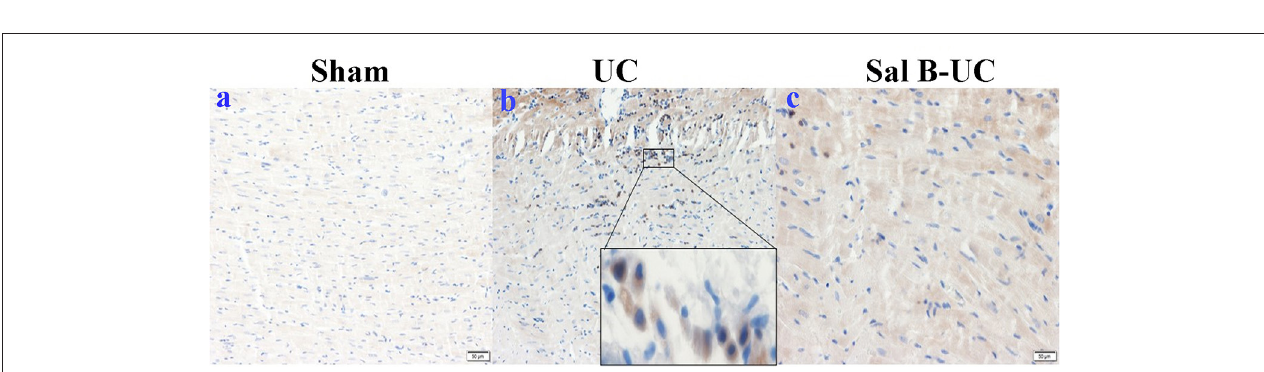
FIGURE 4 | Masson’s trichrome staining. The Masson’s trichrome images of the interstitial and perivascular area in the sham, UC, and Sal B-UC groups (50 µ m). The light blue staining indicates the severity of cardiac fibrosis. In the sham group, fibrosis was not observed at either the interstitial level (A) or the perivascular area (B). In the UC group, severe fibrosis was observed at both interstitial levels (C) and the perivascular area (D) . In the Sal B-UC group, moderate light blue staining was present at the two levels (E,F) .